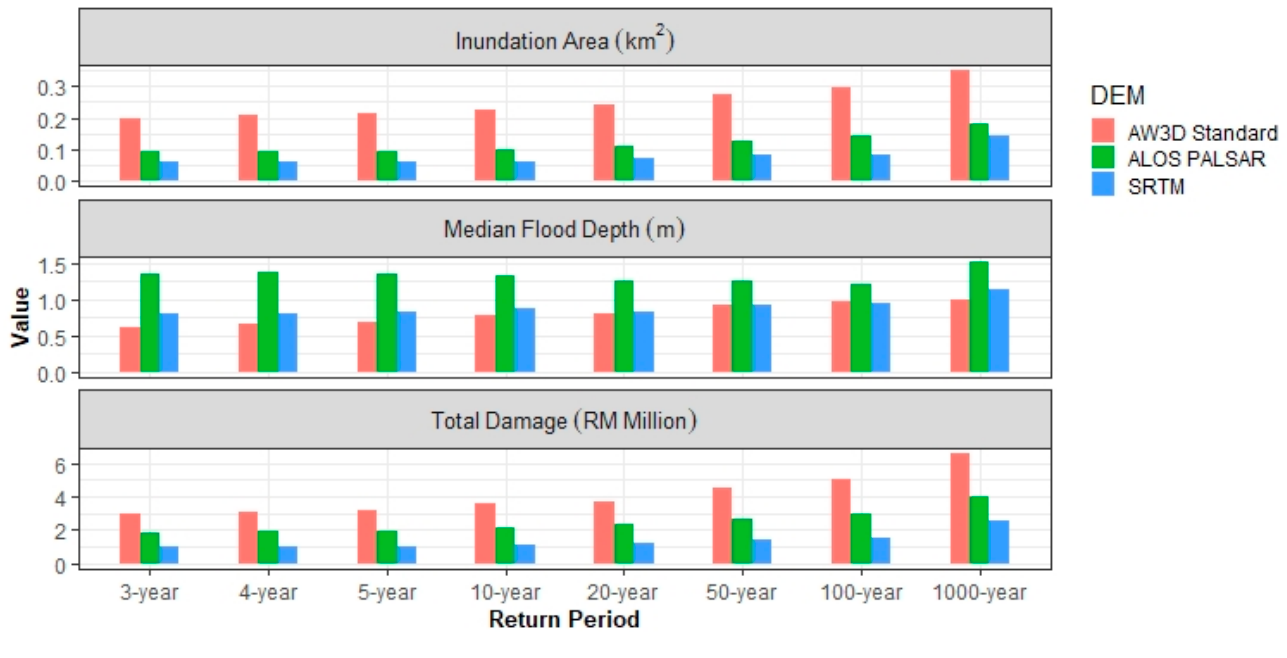
Figure 8. The output comparisons of AW3D Standard, ALOS PALSAR and SRTM.